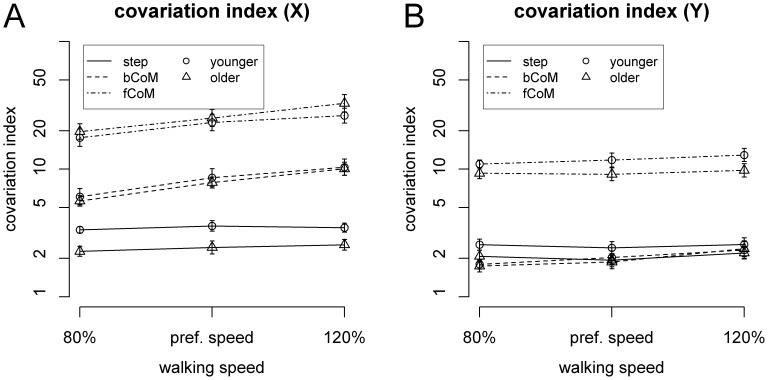
Covariation index in the fore-aft (A) and lateral (B) direction as a function of walking speed and age group.Error bars represent SEM.